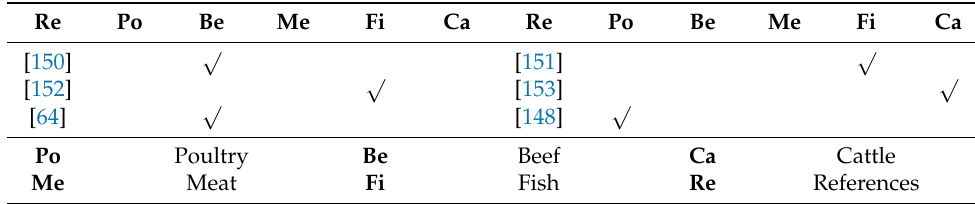
Table 6. Application of blockchain in livestock